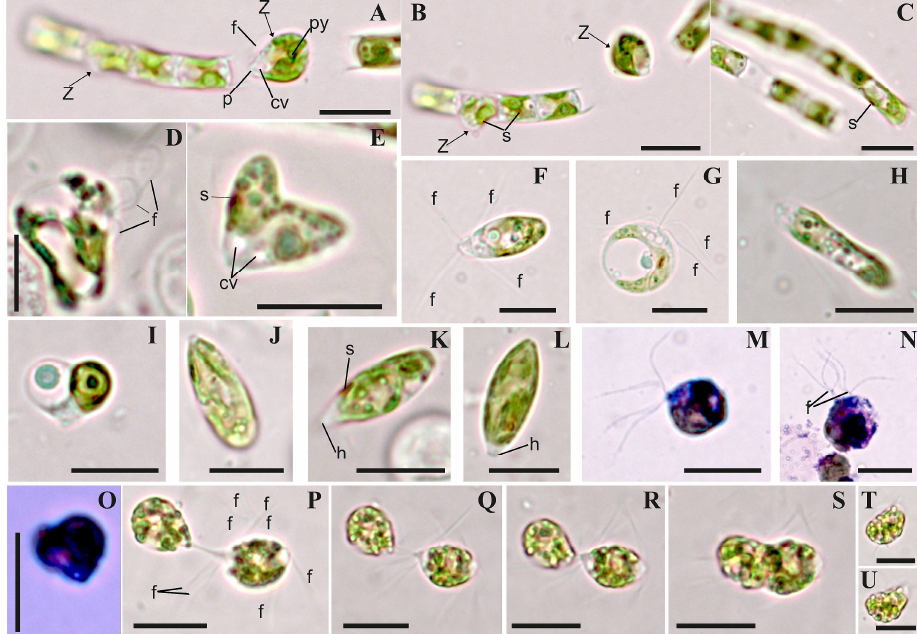
Figure 7. Reproductive and vegetative cells of IRK–A 341. ( A – C ) Liberation of zoospores from mature filament cells. ( A , B , D – I , M – O ) Zoospores of the different shape. ( N ) Zoospore with more than four flagella. ( I – L , O ) Static zoospores without flagella. ( E,P–U ) A merging of two halves of one cell or crossing (?). ( M – O ) Stained with gentian violet. Designations: cv—contractile vacuole; f—flagella, h—holdfast; p—papilla, py—pyrenoid; s—stigma (eyespot); z—zoospore. Scale bars: 10 µm.